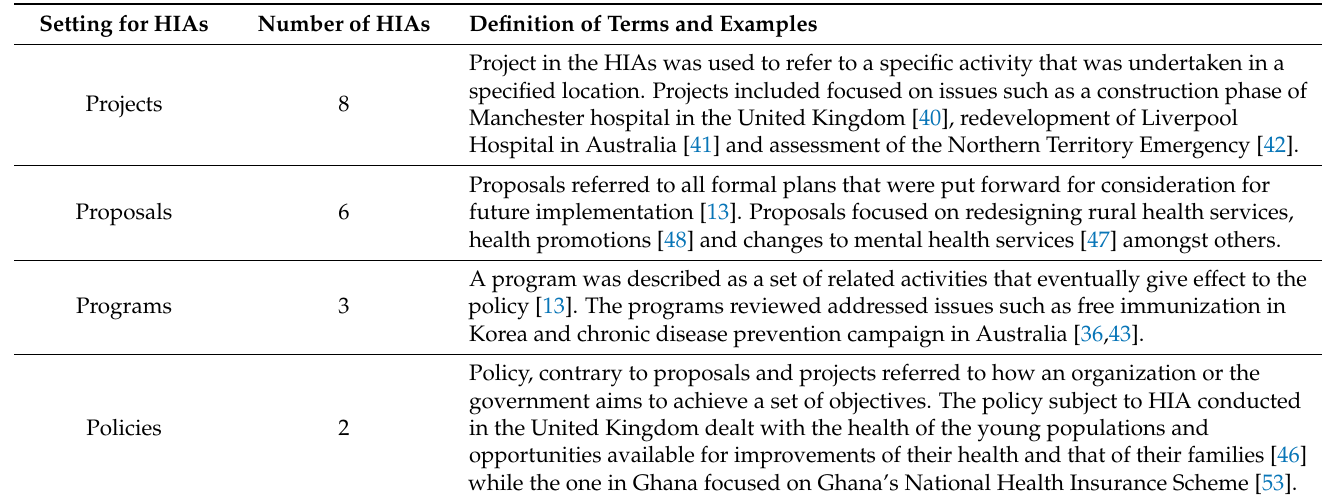
Table 2. Setting for HIAs.